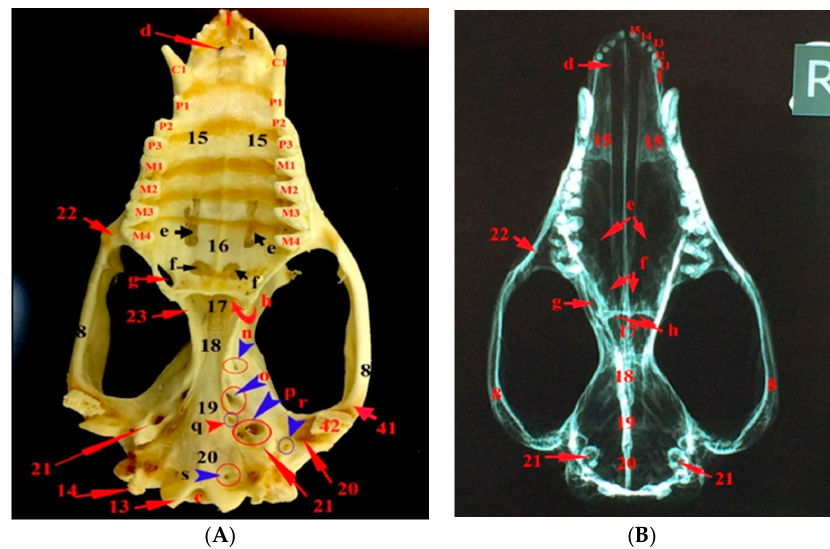
Figure 2. Images showing the gross anatomy ( A ) and radiography ( B ) of the ventral view of the skull of the common opossum. 1. premaxilla bone; 8. zygomatic process of squamosal bone; 14. jugular process; 15. palatine process of maxilla; 16. palatine bone; 17. vomer bone; 18. presphenoid bone; 19. basisphenoid bone; 20. basioccipital bone; 1. tympanic process of the alisphenoid; 22. zygomatic process of maxilla; 23. pterygoid bone; 41. prearticular process; 42. retroarticular process; c. foramen magnum; d. palatine fissure; e. maxillopalatine fenestra; palatine fenestra; g. caudal palatine foramen; h. choana; o. caudal alar foramen; p. carotic canal; q. transverse canal foramen; r. stylomastoid foramen; s. hypoglossal canal; I1–5. upper incisor teeth; C1. upper canine teeth; P1–3. upper premolar teeth; and, M1–4. upper molar teeth.